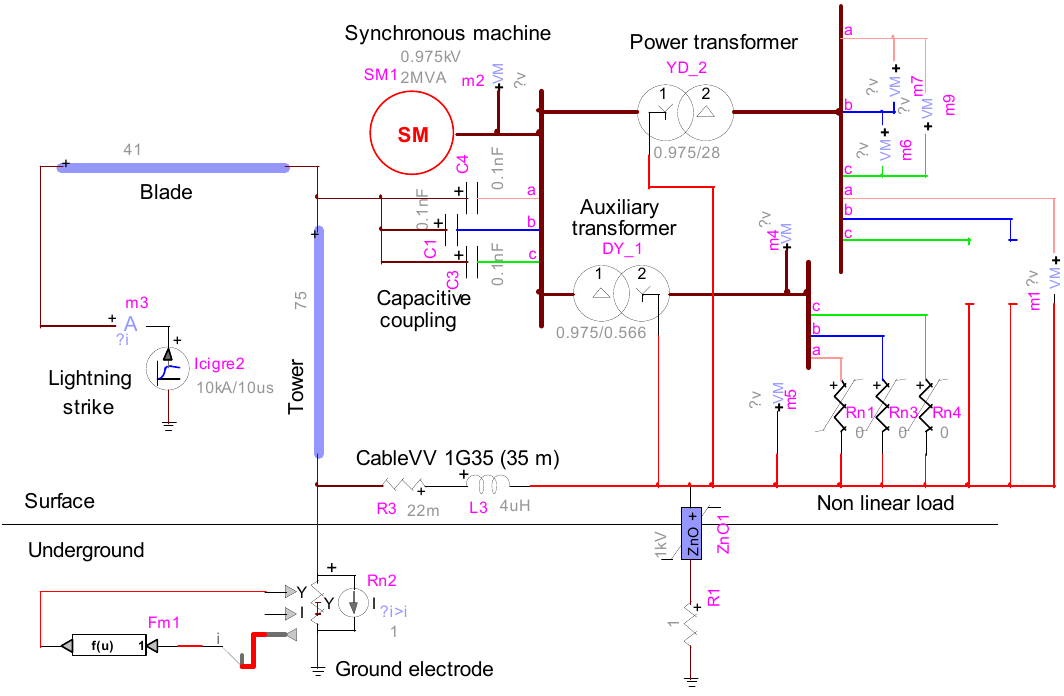
Figure 9. EMTP-RV circuit with SPD.